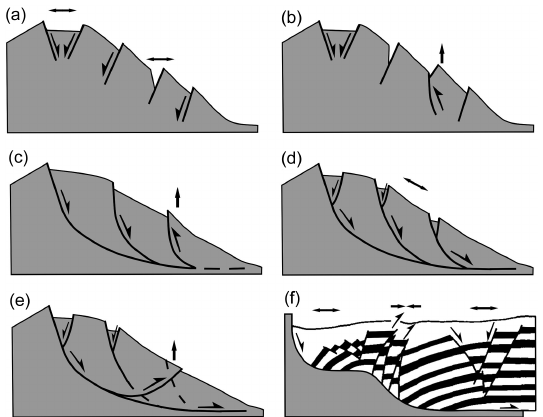
Figure 10. Section views across different models of DSGSDs. (a) Development of extensional structures at a sackung-type DS- GSD; (b) inversion kinematics at a sackung-type DSGSD; (c) trans- lational type with inversion kinematics due to locking of the toe block; (d) well-developed translational type, or block slide type, with antithetic slip planes; (e) same as (d) with reverse movements along an uphill-dipping slip plane; (f) development of reverse slip planes above a basal shear with a complex geometry of the “ramp and flat” type. ( a after Gutiérrez-Santolalla et al., 2005; c and e con- sistent with Jaboyedoff et al., 2013; f modified after McClay and Ellis,